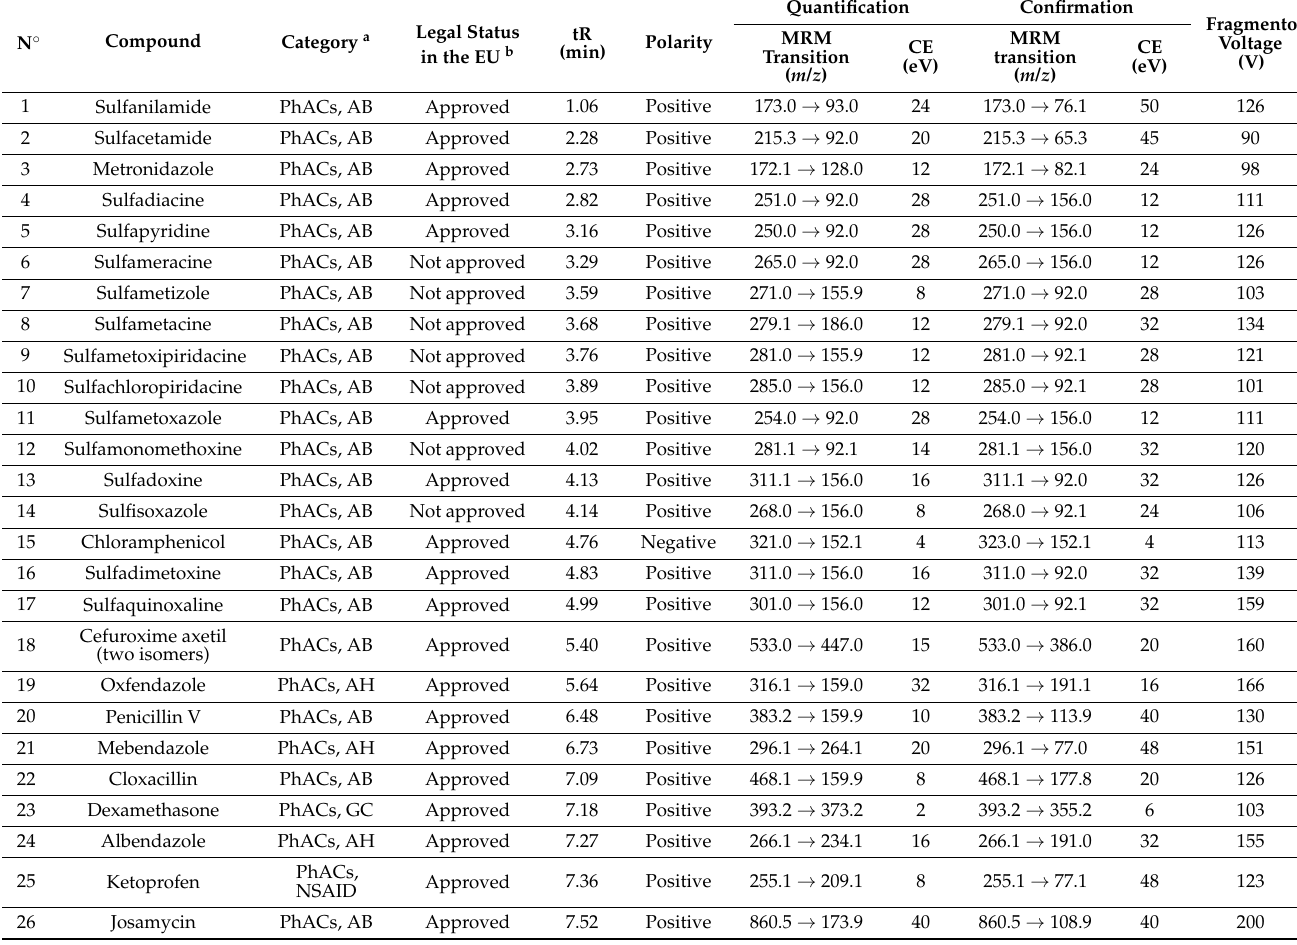
Table 1. Characterization of target compounds by therapeutical classes or biocides, legal status, and their chromatographic and mass spectrometric